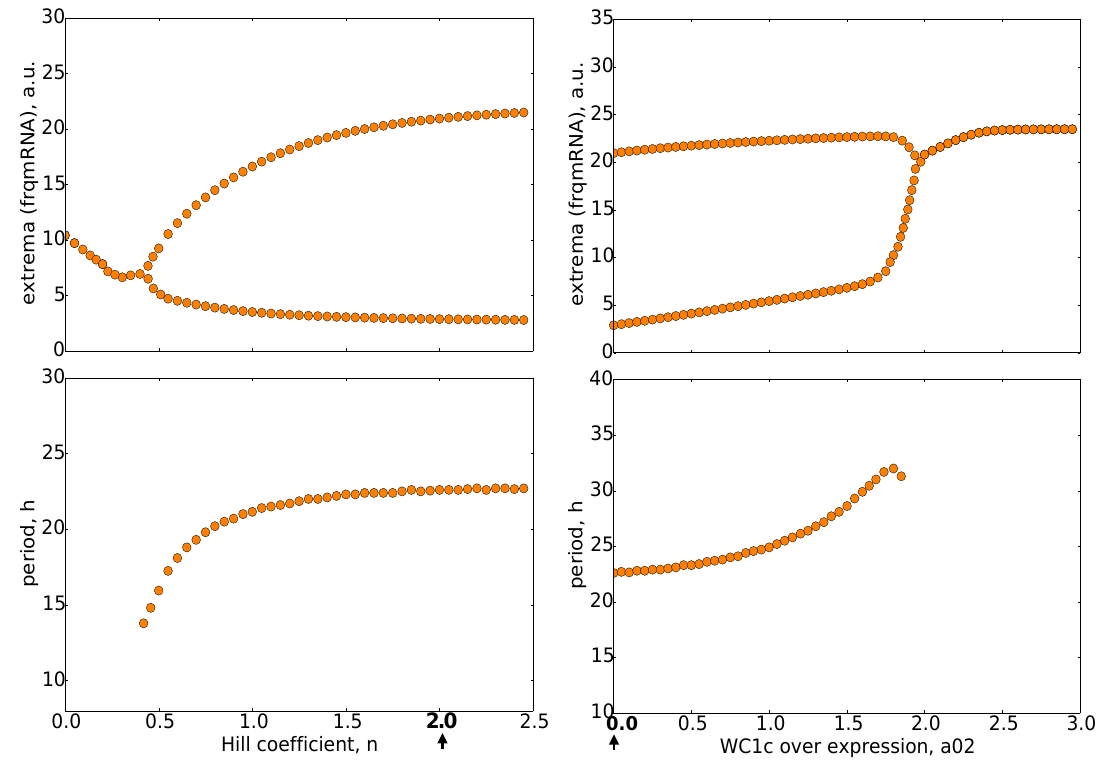
Figure 4. Bifurcation diagrams: The upper graphs show the maxima and minima of oscillations for varying parameters n (Hill coefficient) and a02 (WC1c overexpression). The lower graphs depict the corresponding periods. It turns out that oscillations persist for Hill coefficient n between 0.5 and 2.5, whereas overexpression of WC1 (a02) can terminate rhythms. Default parameter values are marked by bold numbers and